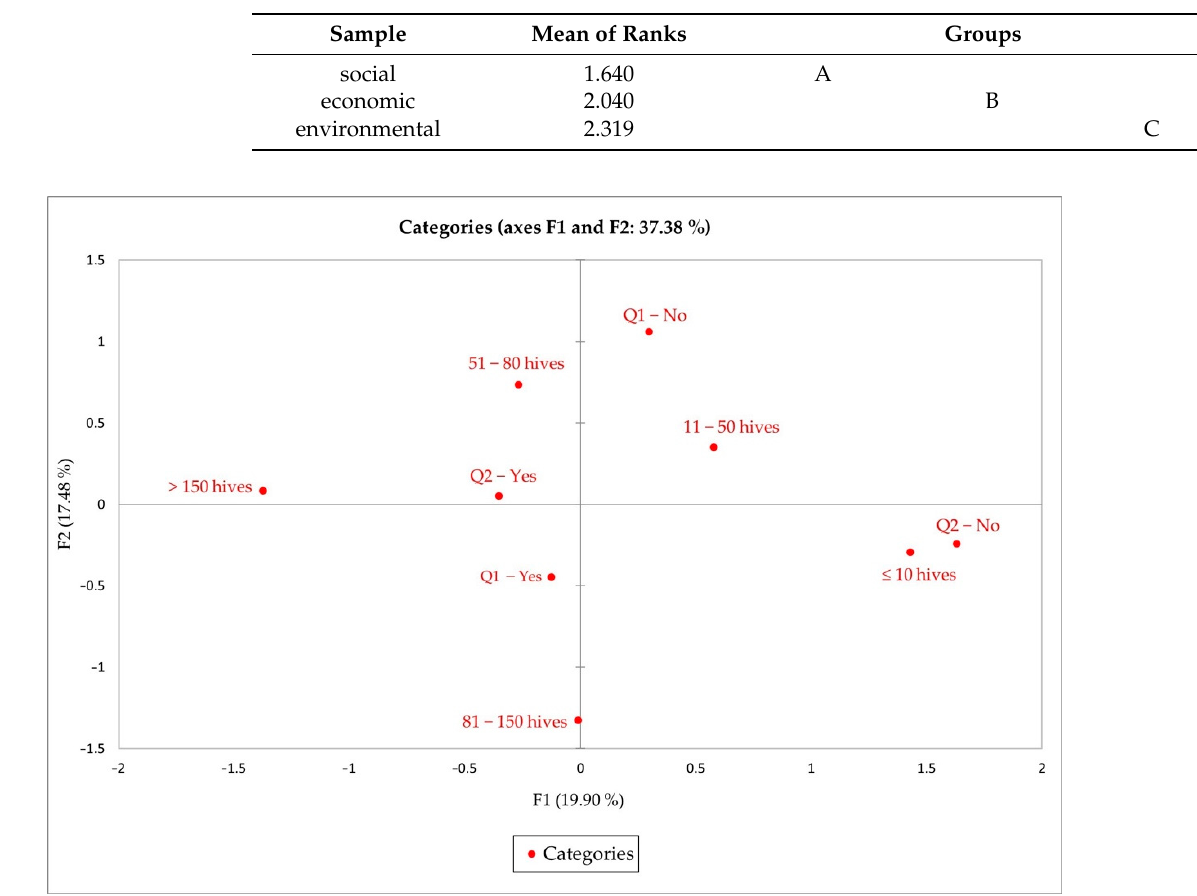
Figure 6. Multiple correspondence analysis (MCA) illustrating two-dimensional plot (F1 versus F2), created by using the following questions: number of hives, awareness about the concept of sustainable beekeeping, and knowledge about organic principles. Each question represented either binary variable with a yes/no response or variable with a multiple responses.